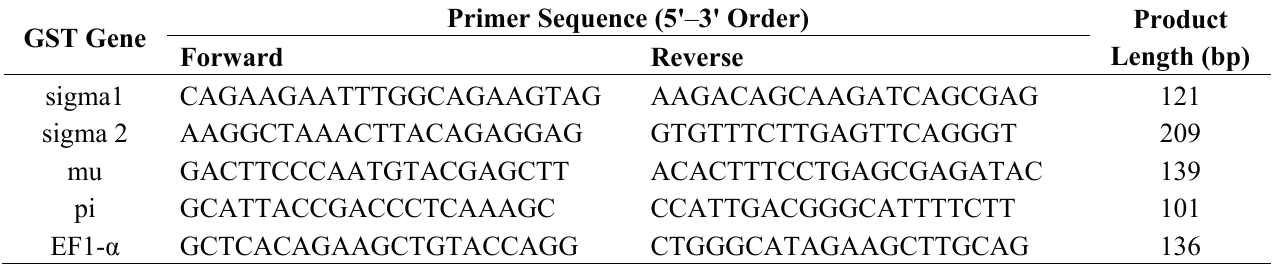
Primer Sequence (5' – 3' Order) Product